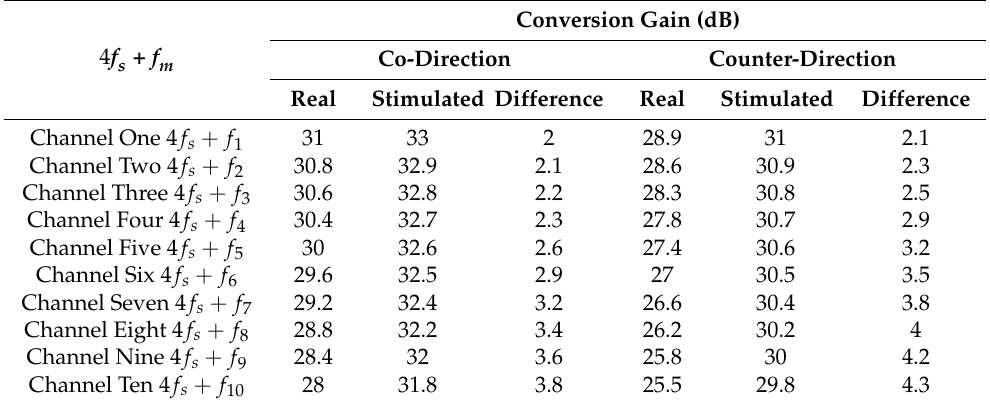
Table 3. Real and stimulated conversion gains of the ten up-converted signals in co- and counter- direction schemas at 4 f s + f m